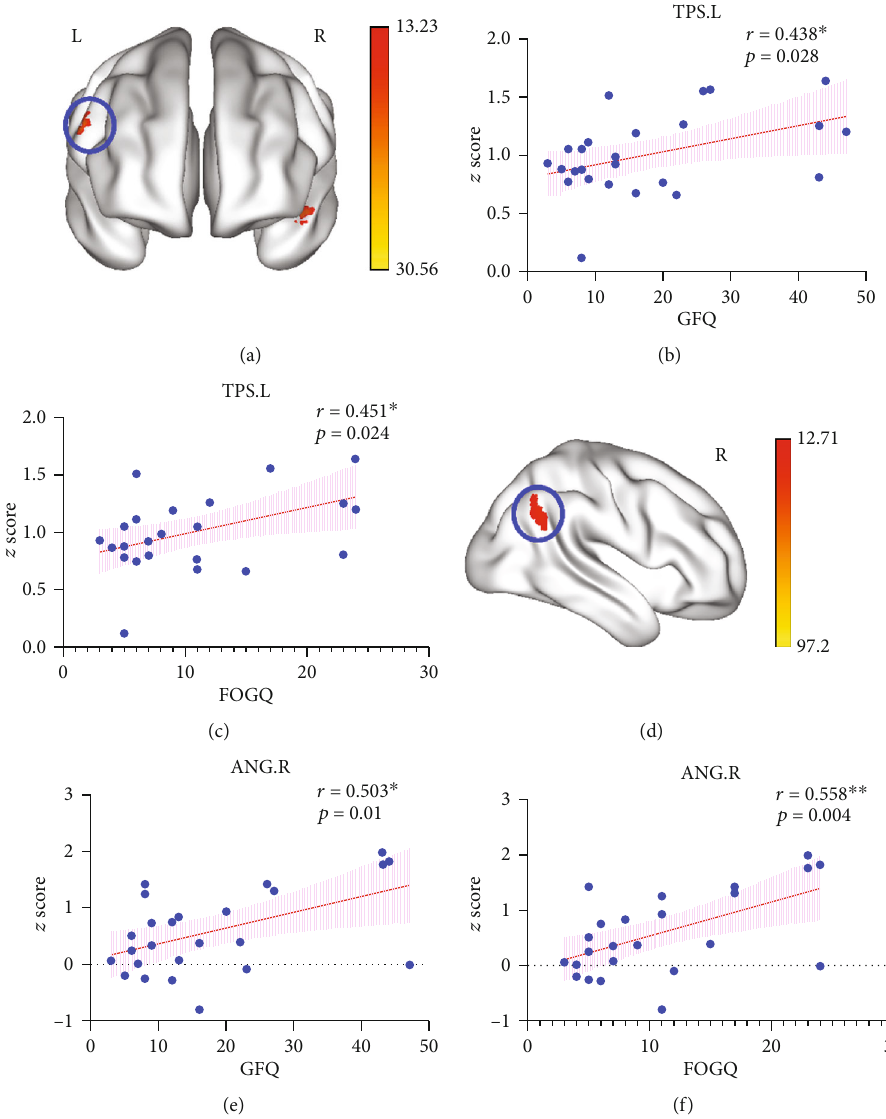
Figure 3: The correlations between brain regions connectivity abnormities and the severity of gait disorders symptoms in FOG+ patients. (a) Threshold maps for the TPS.L of the AUN. (b, c) Altered connectivity in the TPS.L correlated positively with GFQ score ( p = 0 : 028 , rho = 0 : 438 ) and FOGQ score ( p = 0 : 024 , rho = 0 : 451 ). (d) Threshold maps for the ANG.R of the DMN. (e, f) Altered connectivity in the ANG.R correlated positively with GFQ score ( p = 0 : 01 , rho = 0 : 503 ) and FOGQ score ( p = 0 : 004 , rho = 0 : 558 ). FOG+: Parkinson ’ s disease with freezing of gait; L/R: left/right hemisphere; AUN: auditory network; TPS: temporal pole: superior temporal gyrus; DMN: default mode network; ANG: angular gyrus; GFQ: Gait and Falls Questionnaire; FOGQ: Freezing of Gait